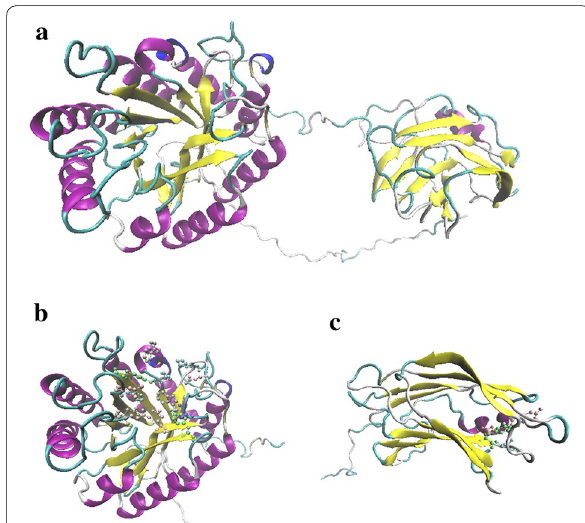
Fig. 2 Homology modeling using the RaptorX online server for Cel-5A. a 3D structure of Cel-5A. b Active sites of the catalytic domain forming a pocket. c Active sites of the CBM